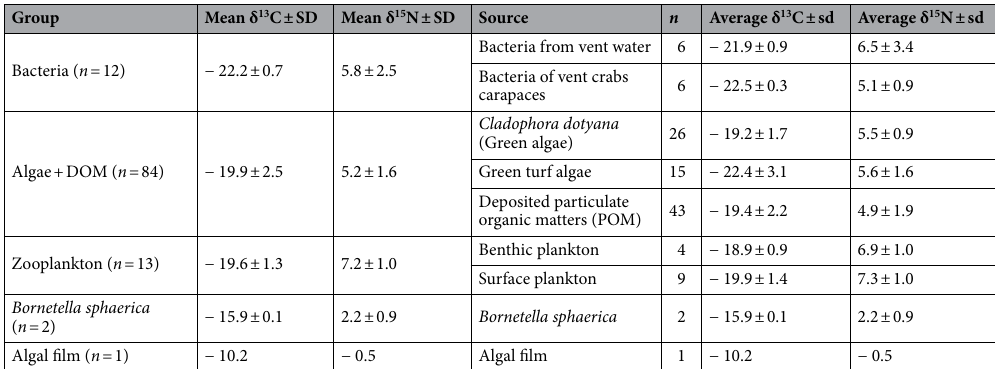
Table 1. δ 13 C and δ 15 N values of the five basal resource groups and their original sources collected from the Kueishan Island shallow-water vents. n, number of samples. Statistical analysis: Bacteria from vent water and vent crab carapaces: (t-tests: [δ 13 C] t 0.05(2),9 = 0.84, p = 0.44; [δ 15 N] t 0.05(2),9 = 0.46, p = 0.67). Green algae, Green turf algae and POM: (One way ANOVA [δ 13 C]: F 2,81 = 11.05; p < 0.05, SNK test: Green algae = POM > Green turf algae; [δ 15 N], F 2,81 = 1.74; p > 0.05). Surface and Benthic zooplankton: (t-tests: [δ 13 C] t 0.05(2),11 = -1.33, p = 0.22; [δ 15 N] t 0.05(2),11 = 0.64, p = 0.53).